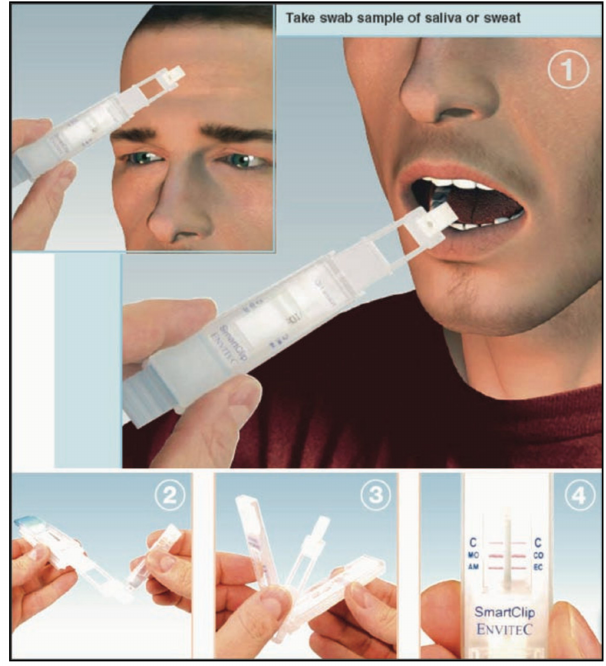
Figure 15. Smartclip device. ( 1 ) A swab of saliva or sweat is taken. ( 2 ) A buffer solution is added. ( 3 ) The system is closed. ( 4 ) The result can be read from indicator strips (reproduced with permission from Springer